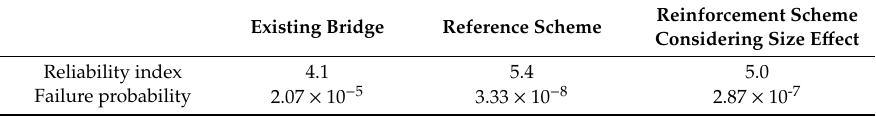
Table 4. Reliability indexes of the considered bridge strengthened with di ff erent